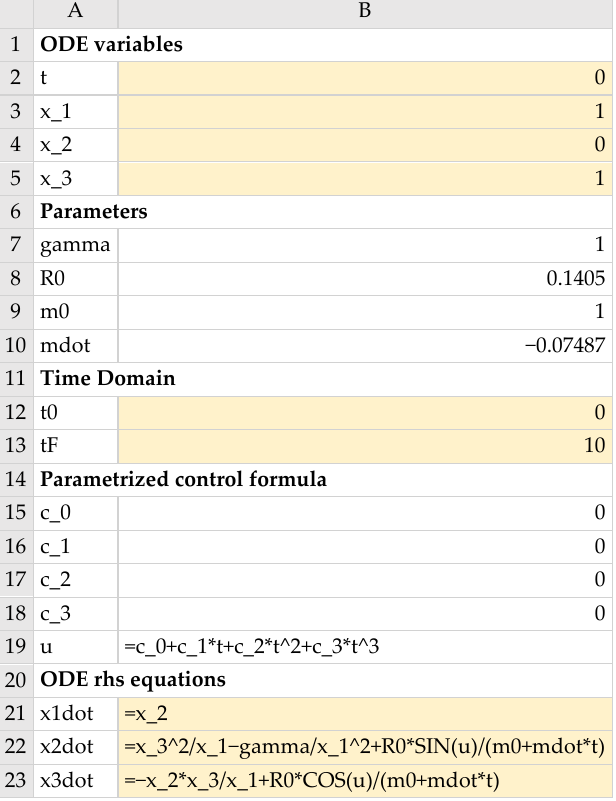
Figure 20. Spreadsheet model for the IVP (32)–(35) with parametrized control function. The colored ranges are input parameters for IVSOLVE Formula (37). Table 5. Formula definitions used for solving optimal control problem (31)–(36).